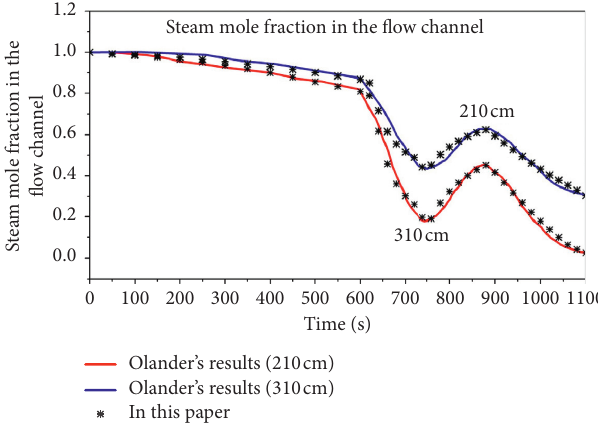
Figure 5: Comparison of steam mole fractions in the flow